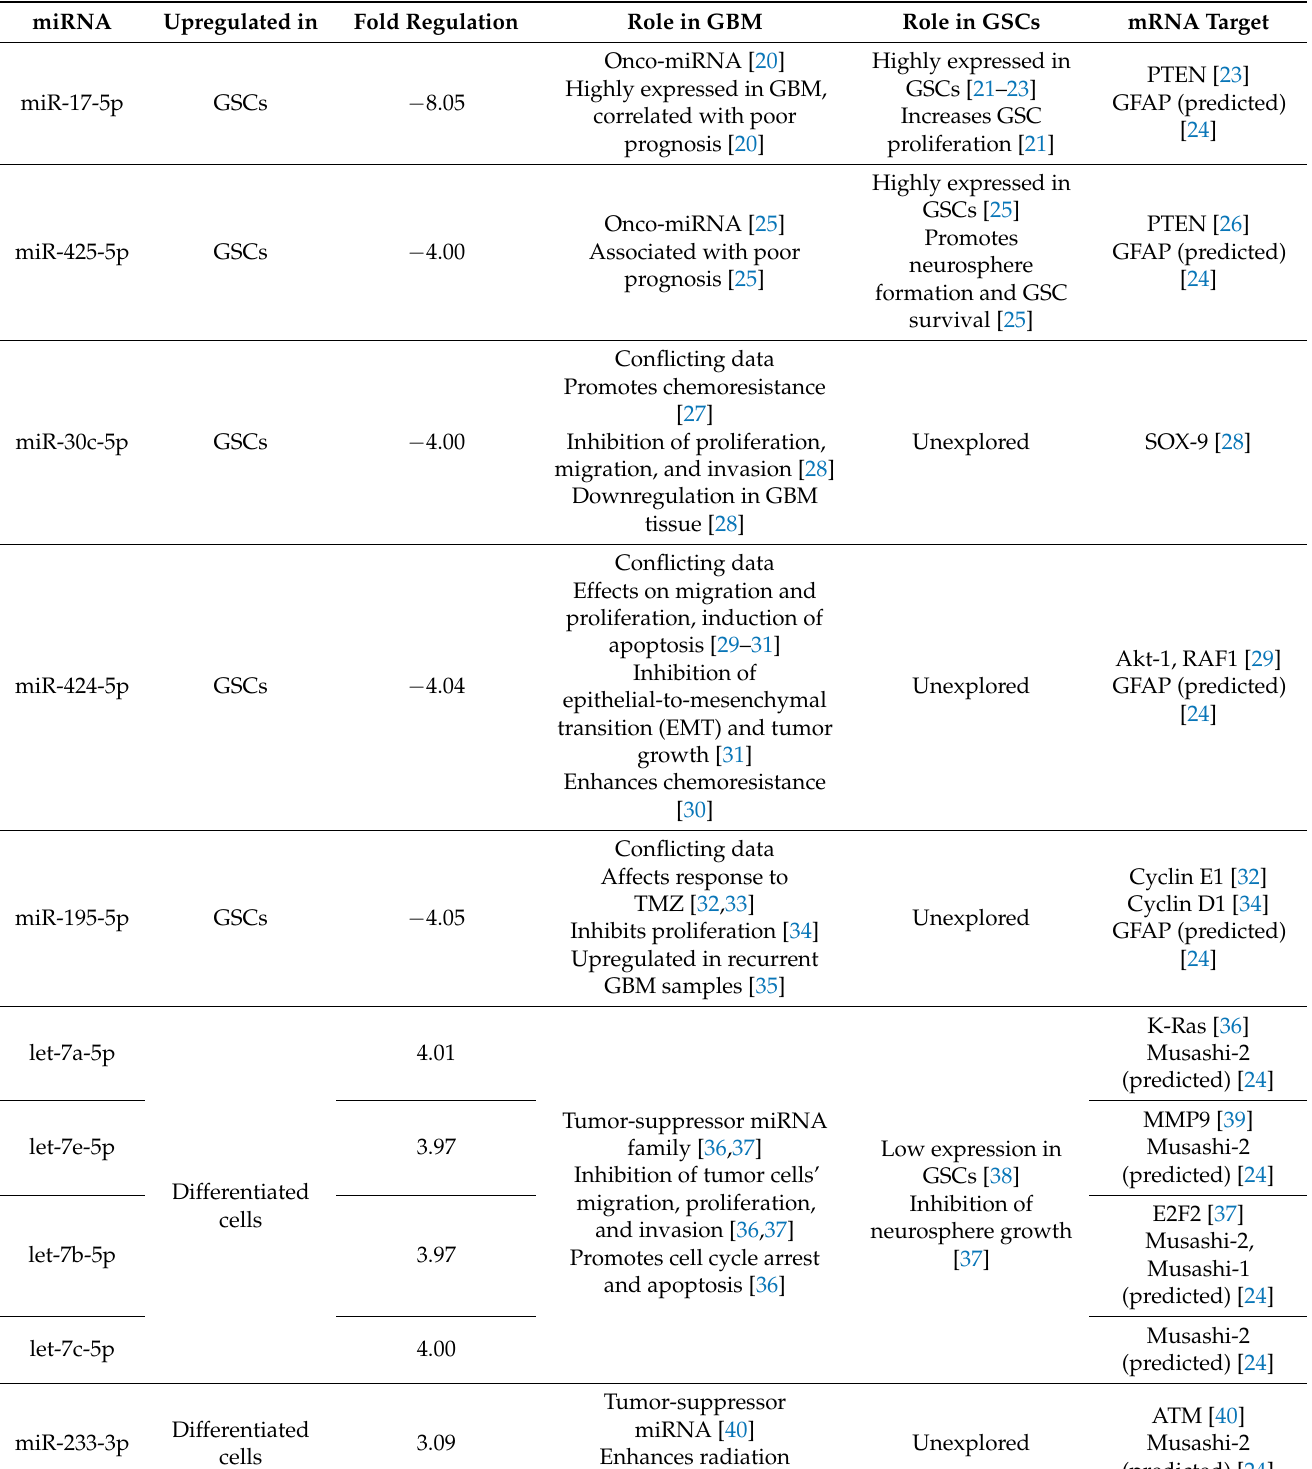
Table 2. Literature review results on highly dysregulated miRNAs identified in the PCR array. The table includes PCR array results indicated by fold regulation and published data on highly dysregulated miRNAs. We focused on the general role of each miRNA in GBM and their potential roles in GSCs. Plus, reported functionally relevant mRNA targets and predicted target genes directly involved in a GSC or differentiated state, respectively, are listed. For miRNA target prediction, the online software miRPathDB v2.0 was